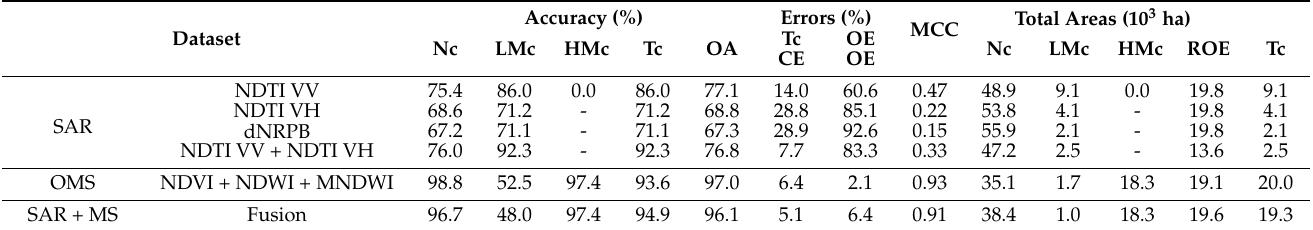
Table 11. Summary of the confusion matrix parameters and Matthews Correlation Coefficient (MCC) obtained for the Leiria National Forest fire, in comparison to the Reference Observed